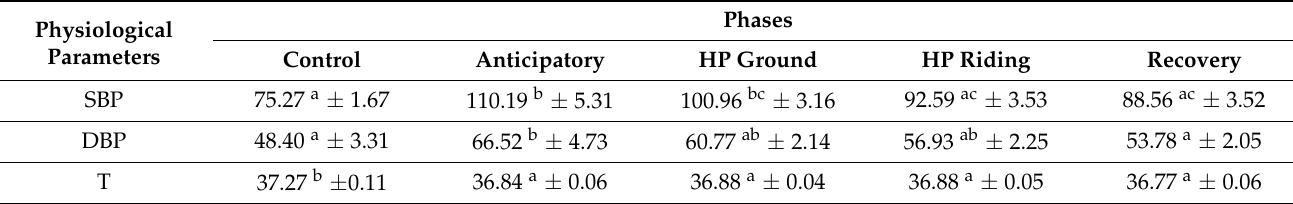
Figure 2. Mean values + SEM of the respiratory rate of the horses in the control and the anticipatory phases, the HP ground and HP riding phases (horse-patient interaction on the ground and on horse- back, respectively) and the recovery phase. The asterisk indicates that the values were significantly higher in the HP riding than in the HP ground and recovery phases ( p < 0.05). Table 4. Mean values ± SEM of the blood pressure and the temperature that were measured in the horses during the control and the anticipatory phases, HP ground and HP riding phases (horse-patient interaction on the ground and on horseback, respectively) and the recovery